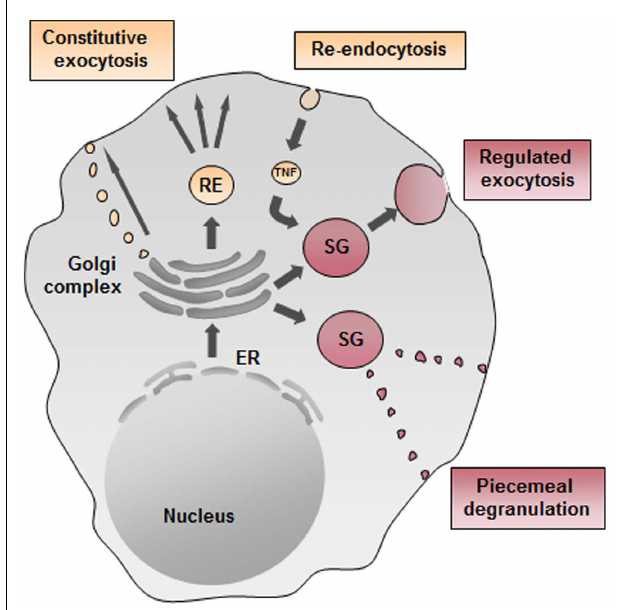
FIGURE 3 | Possible cytokine secretion pathways in mast cells. Cytokine secretion may occur constitutively through small vesicular carriers or through recycling endosomes (ER) as described forTNF in macrophages. Moreover,TNF could get re-endocytosed from the plasma membrane and transported into secretory granules (SG) and then rapidly released upon stimulation. Another possible pathway of regulated exocytosis in mast cells may be piecemeal degranulation as reported for